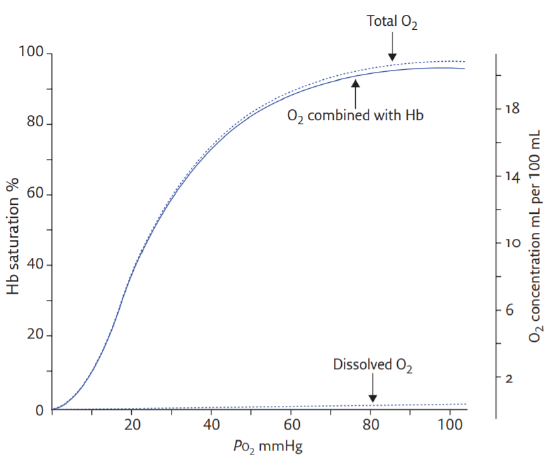
Fig. 1. Oxygen hemoglobin dissociation curve (solid curve); Total oxygen content of blood (top dotted curve) and amount of oxygen in the dissolved form (bottom dotted line) assuming normal hemoglobin (Hb) concentration (15 g/dL). PO : Partial pressure 2 of oxygen in blood. [Reproduced from Collins J-A et al. European Respiratory Society 2015 (CC BY-NC